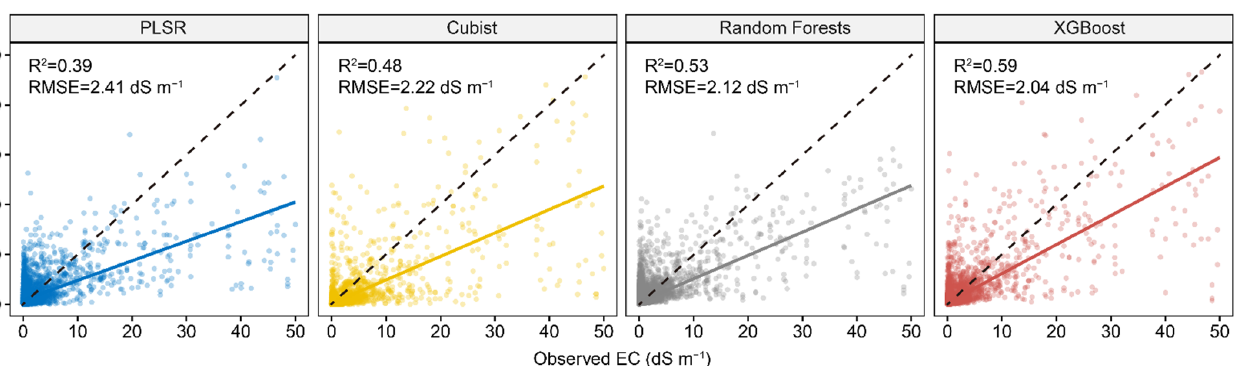
Figure 3. Scatter plots of four spectral predictive models using full spectra. The solid line is a fitted line for each model, whereas the dashed line is the 1:1 line. line for each model, whereas the dashed line is the 1:1 line.